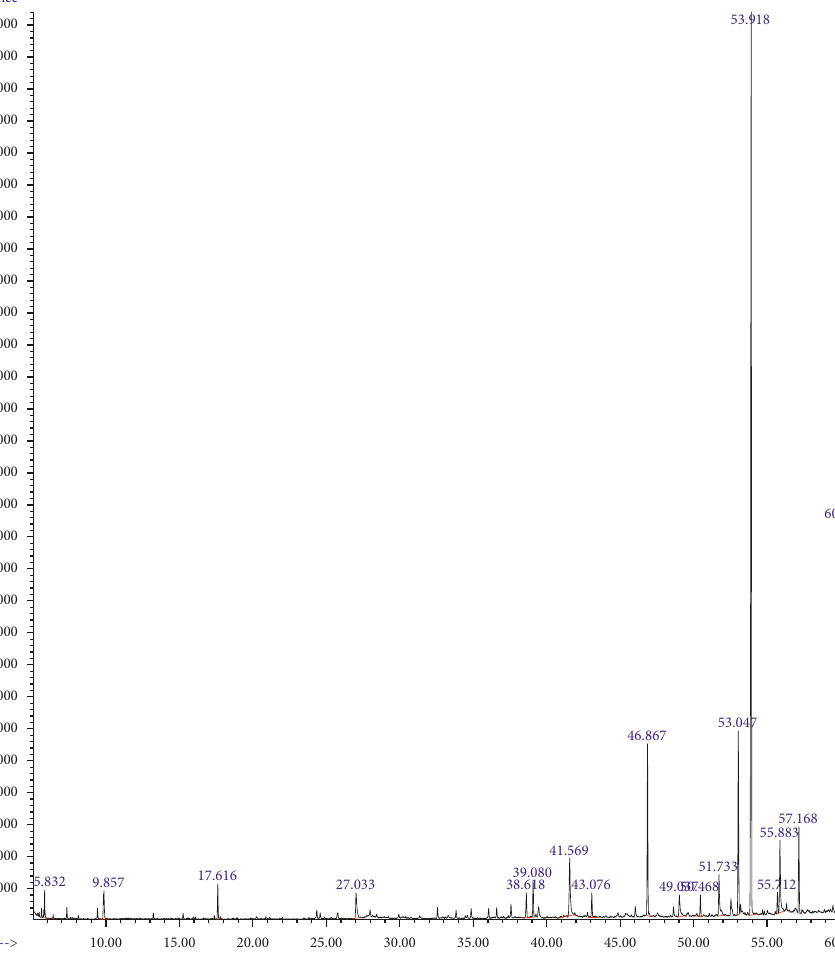
Figure 3: GC-MS chromatogram of acetone extract of N.